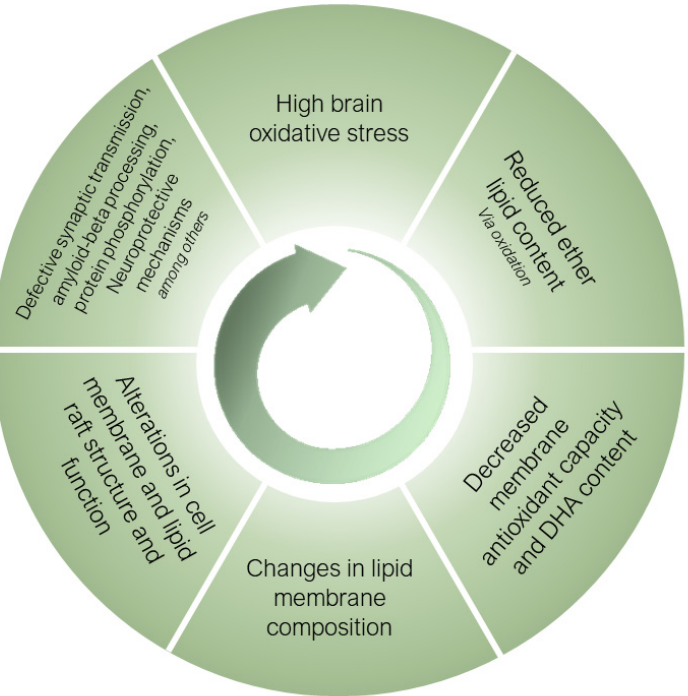
Figure 3. Mechanistic pathway for the potential role of ether lipids in the pathogenesis of sporadic Alzheimer’s disease. For an explanation, see main text.